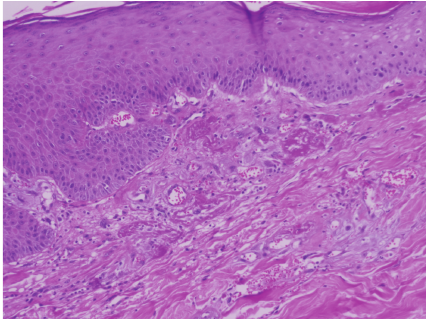
Figure 1: Ulcered, atrophic plaque with hypopigmentation and hyperpigmentation, as well as superficial telangiectasia.